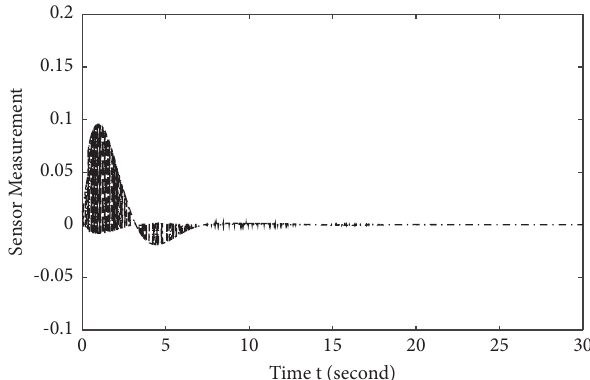
Figure 2: Sensor measurement y